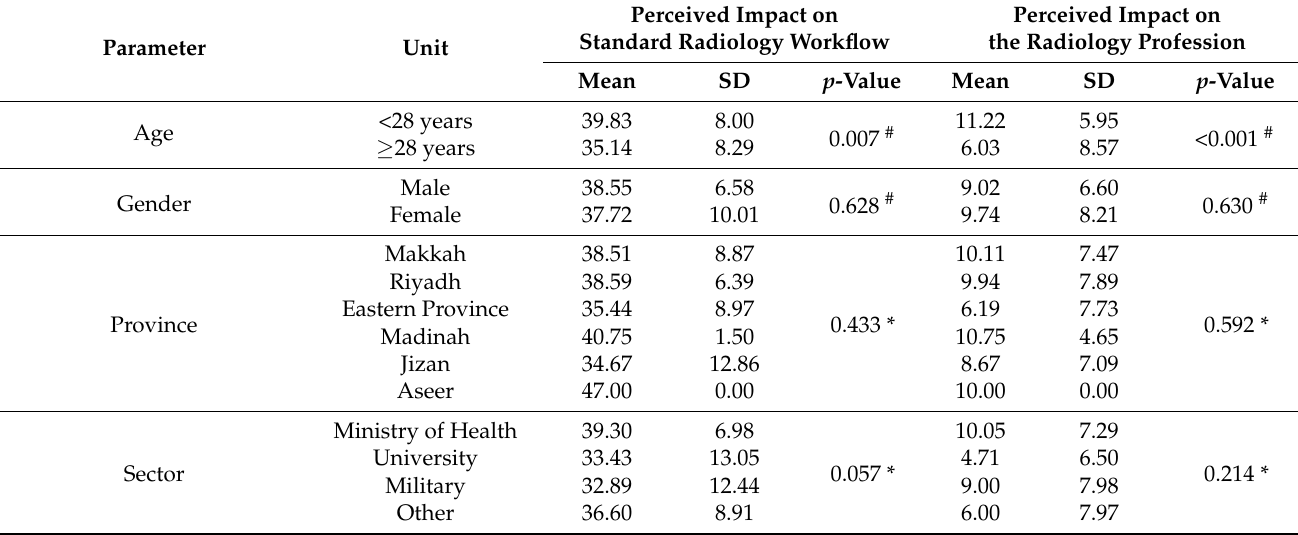
Table 4. Factors associated with perceived impact of AI on standard radiology workflow and on the radiology